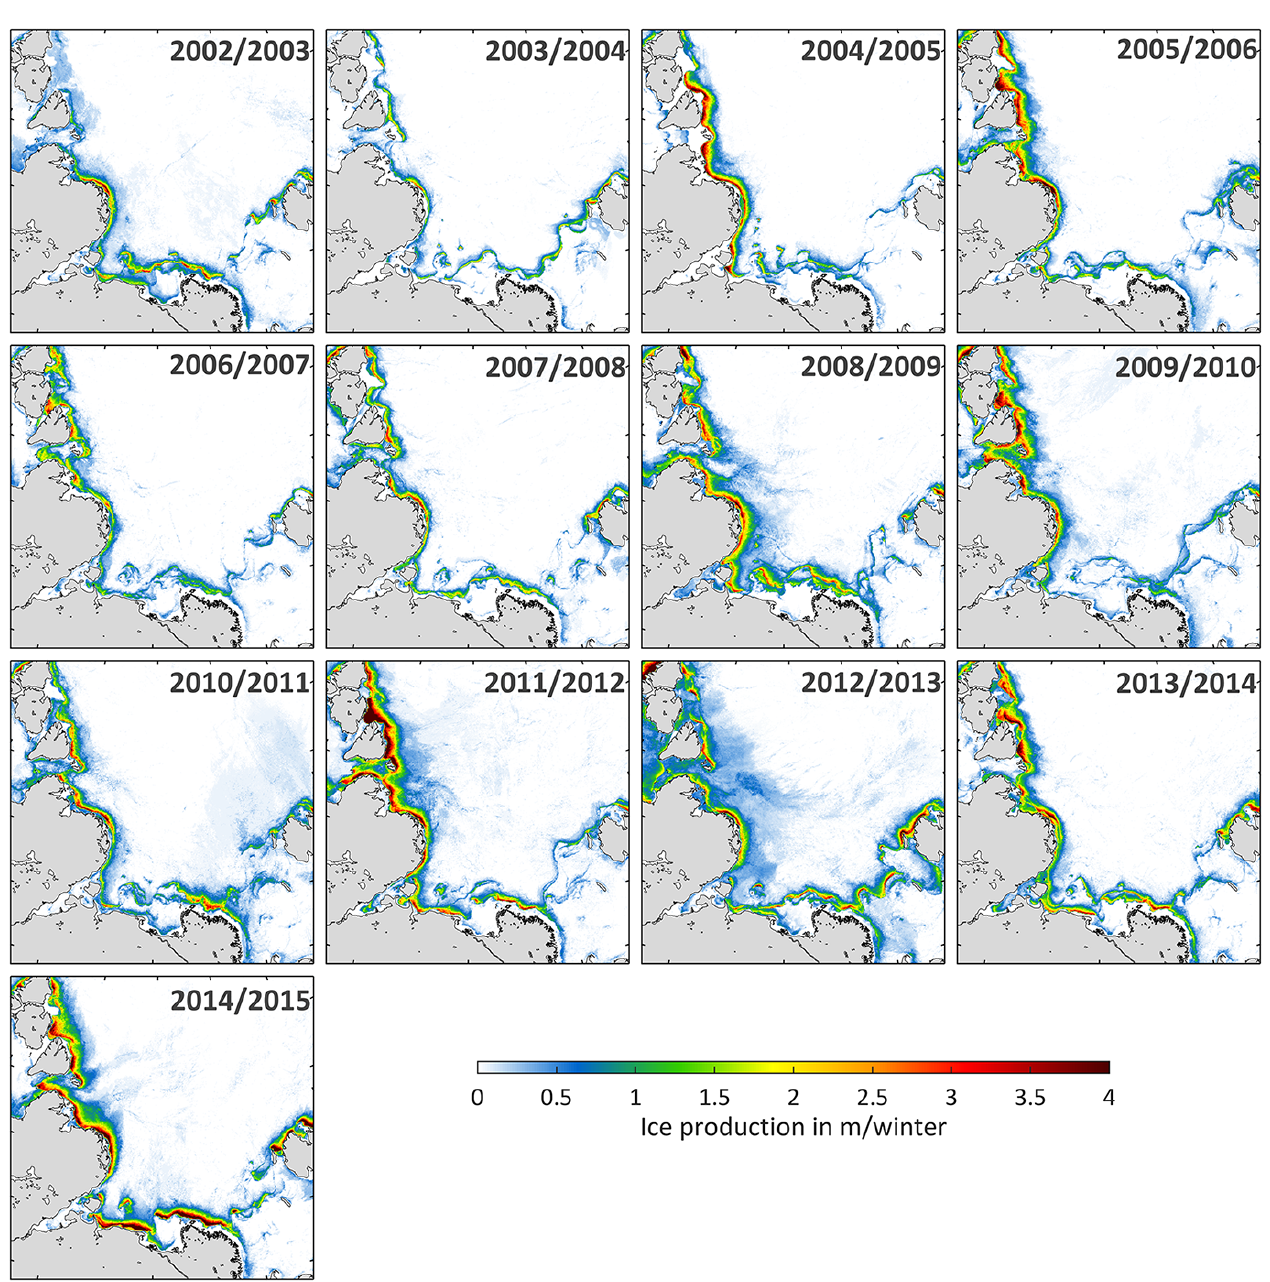
Figure 11. Overview of winter (November to March) accumulated ice production (m per winter) in the Laptev Sea region between 2002/2003 and